Question: Write a descriptive caption for this figure.
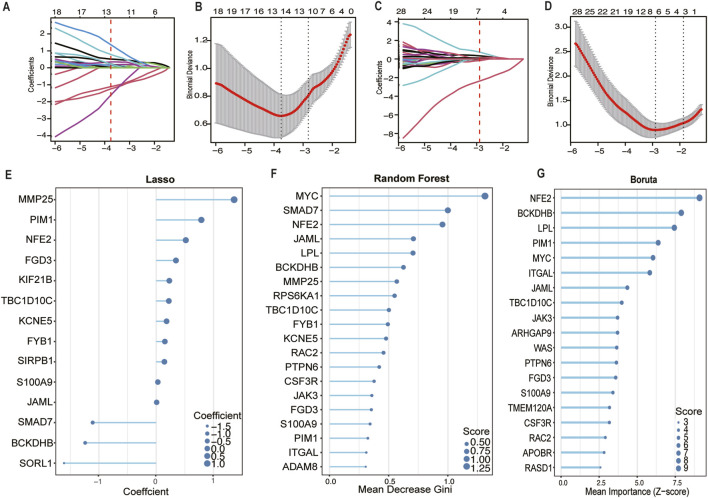
Answer: Screening of feature genes using LASSO, random forest, and Boruta algorithms. (A–D) LASSO regression feature selection and optimal parameter determination based on ten-fold cross-validation. (E–G) Core feature genes identified by LASSO, random forest, and Boruta algorithms, along with assessment of gene importance.